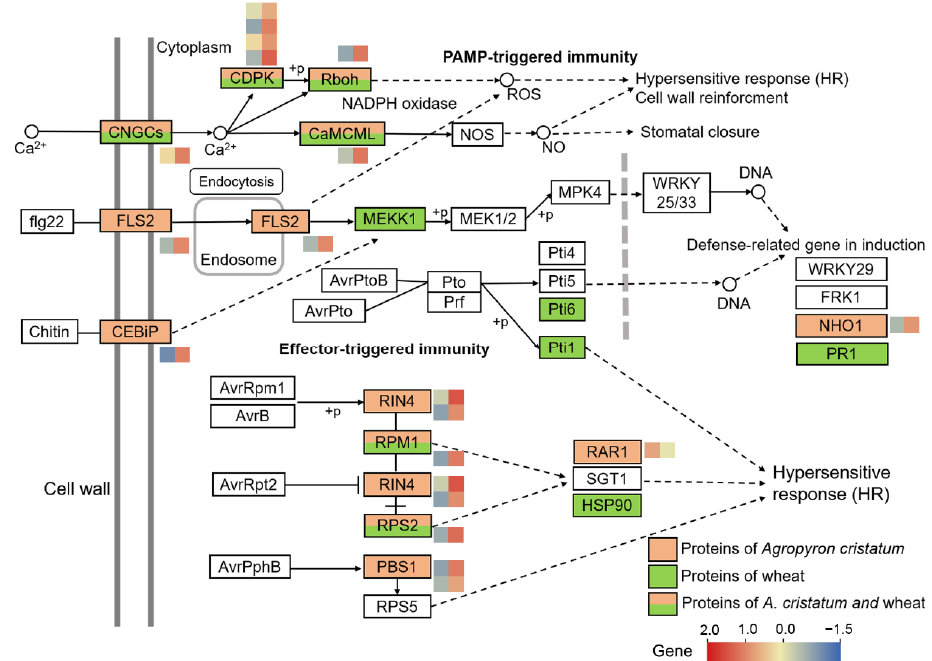
Figure 6. Schematic diagram of the plant – pathogen interaction pathway involving DEGs in the addition line II-9-3. Red boxes: proteins encoded by genes of A. cristatum ; green boxes: proteins encoded by genes of wheat. Genes from A. cristatum encoding these enzymes as well as their expression are presented in the heatmap.